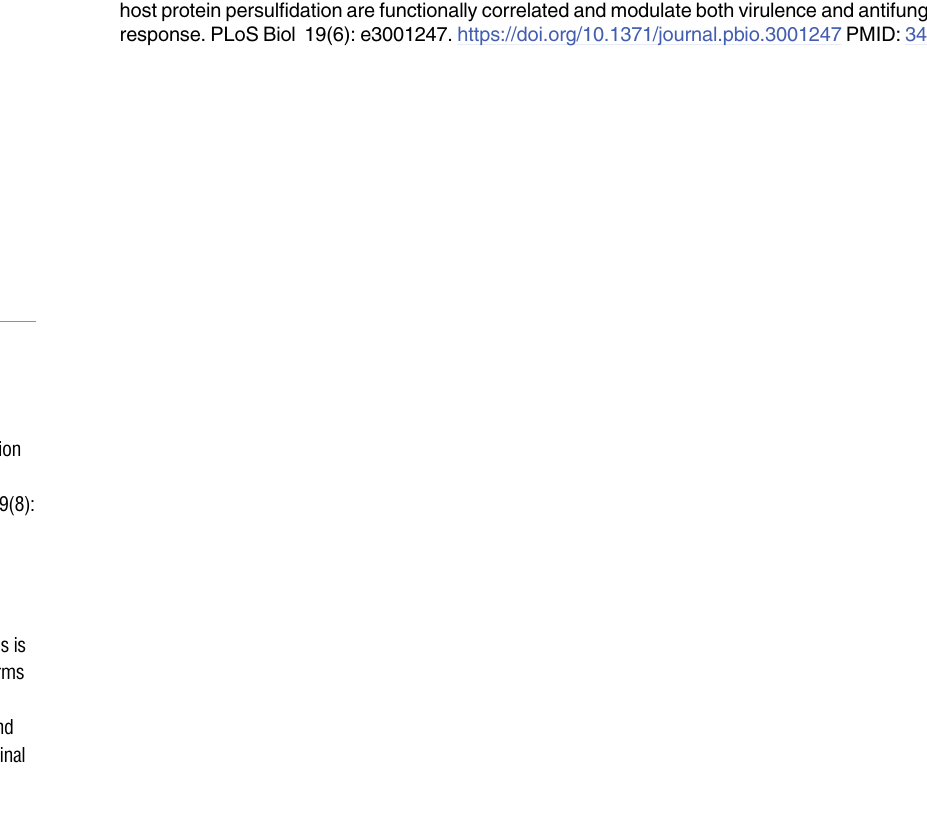
S2 Table. List of proteins of the persulfidated enriched fraction identified by mass